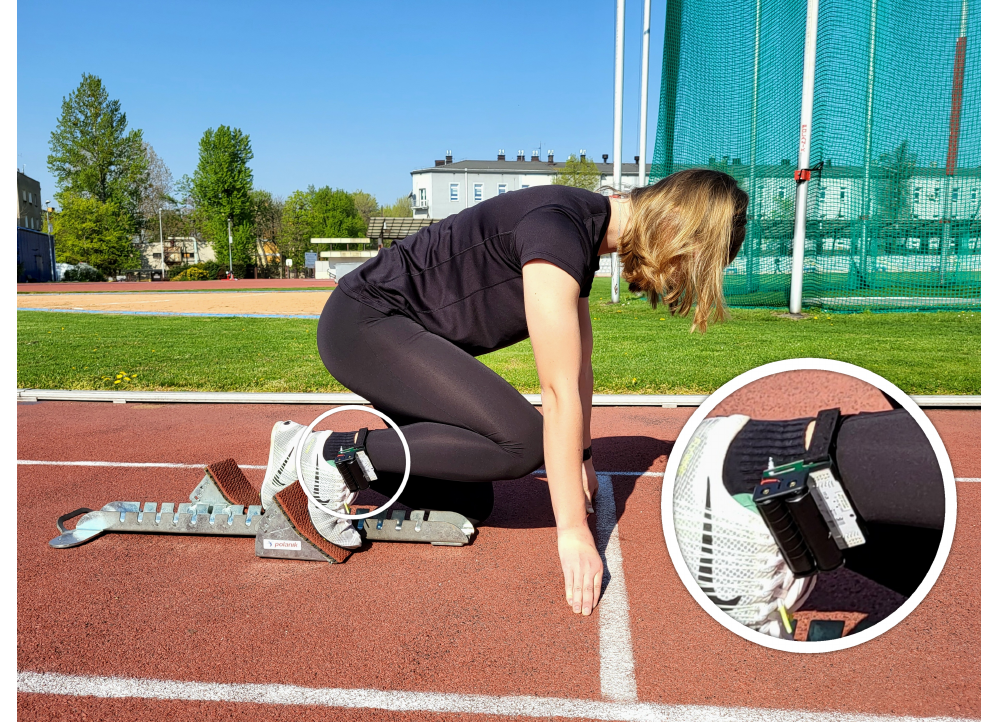
Figure 14. Photo of the hardware part of the system taken during